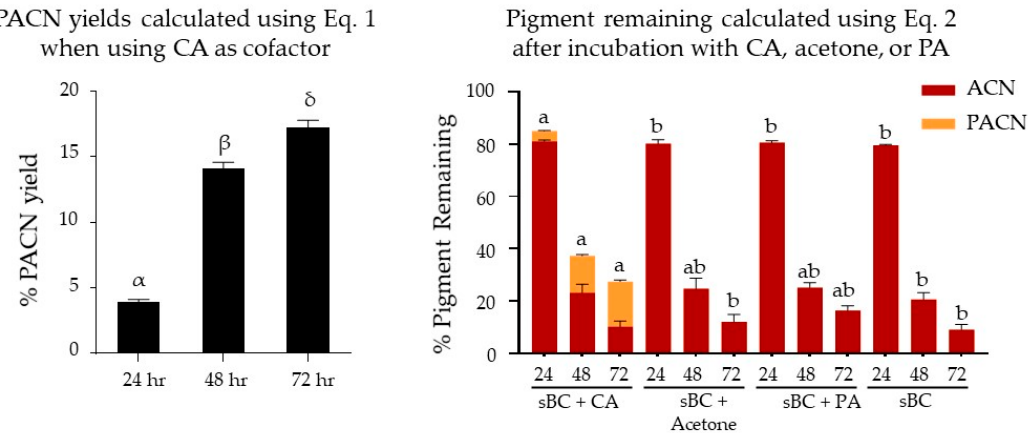
Figure 2. Pyranoanthocyanin yield (%PACN) with caffeic acid (CA) and pigment remaining (%) after incubation with different cofactors for 24, 48, and 72 h at 45 °C with cyanidin-glycosides (from saponified black carrot, sBC). Different Greek letters show significant differences among time points at a 0.05 level. Different letters show statistically significant differences among cofactors at the same time point at a 0.05 level. Results are expressed as means ± standard error ( n = 3). ACN: anthocyanin, PA: pyruvic